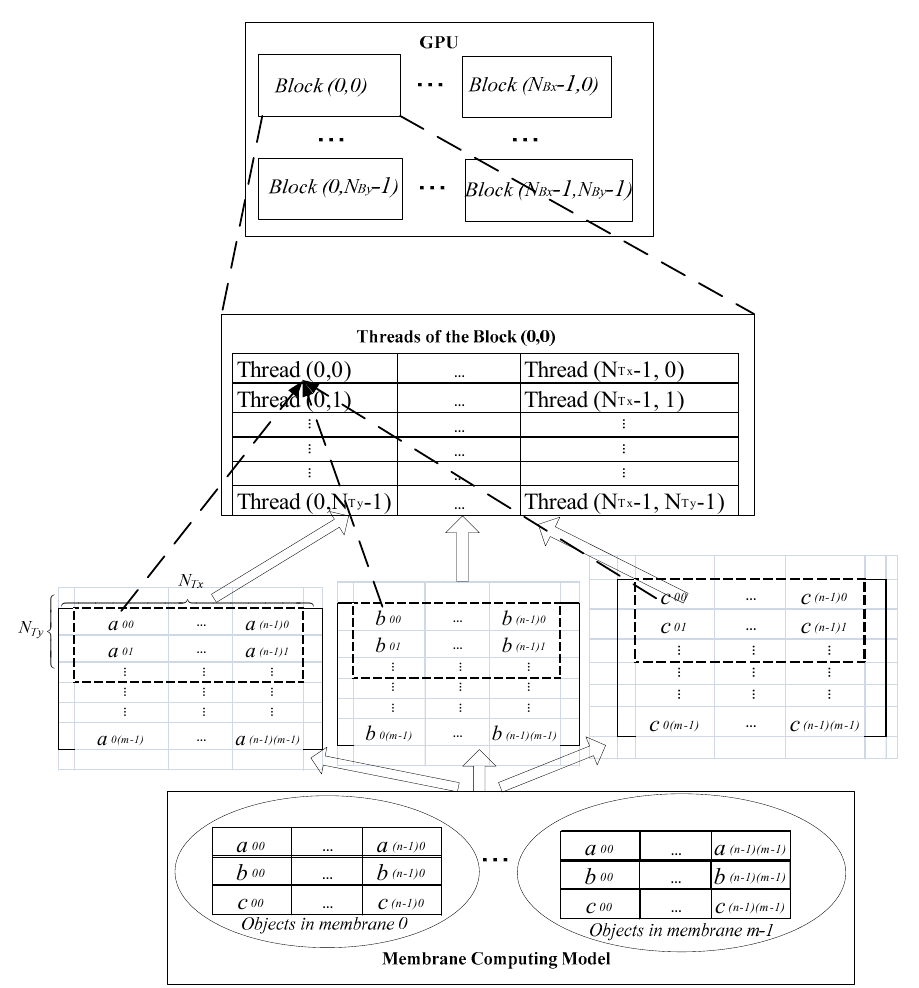
Figure 4. Representation of a membrane system as matrices.